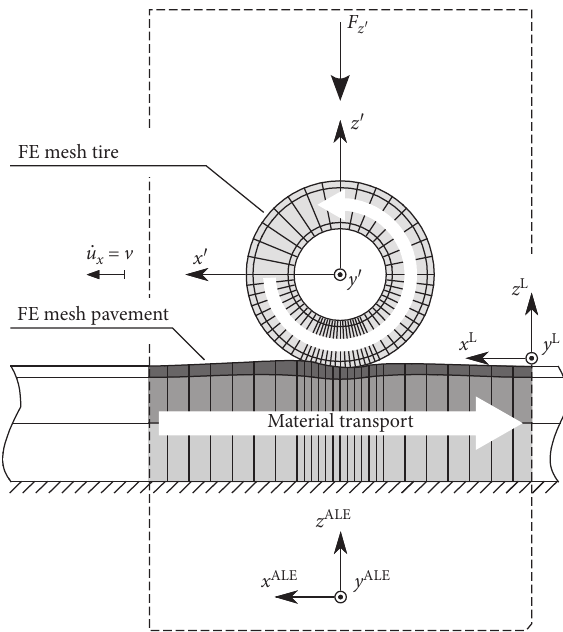
Figure 3: FE tire-pavement model for the structural analysis of the tire-pavement interaction using an ALE framework for both tire and